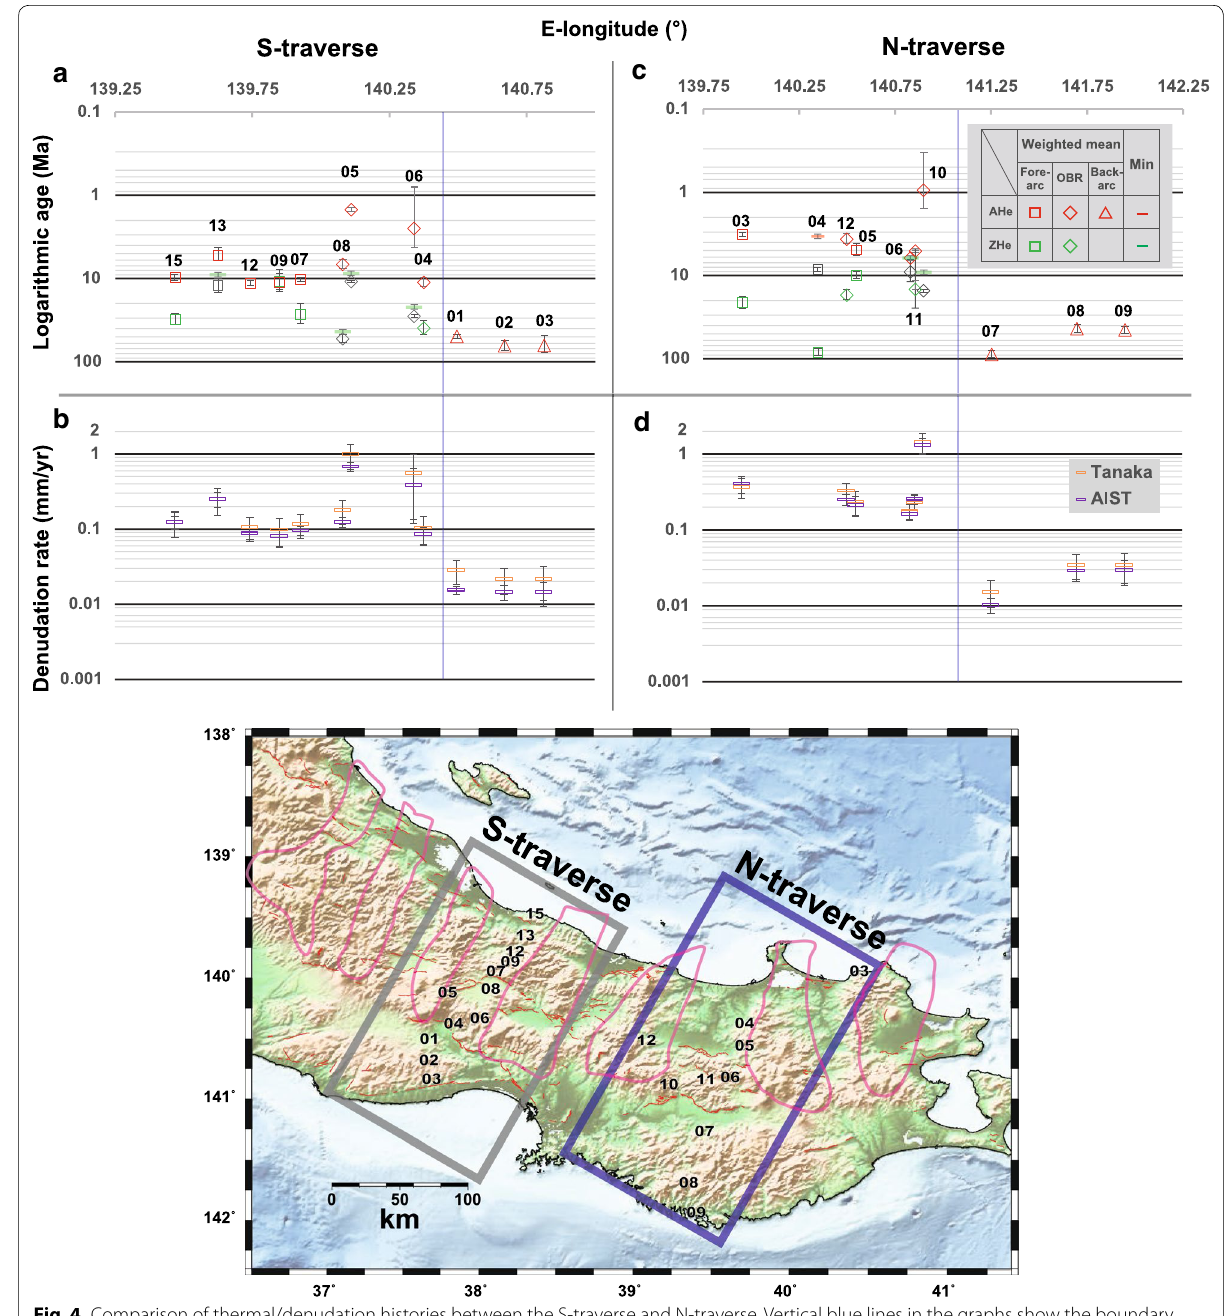
Fig. 4 Comparison of thermal/denudation histories between the S-traverse and N-traverse. Vertical blue lines in the graphs show the boundary between the fore-arc side and the OBR/back-arc side. Numbers on the map denote the sample localities in the N- and S-traverse corresponding to the sample codes in the graphs ( a , c ). Pink lines show hot fingers (Tamura et al. 2002). The map was drawn using GMT (Wessel and Smith 1991) and 30 arc-second grid of the General Bathymetric Chart of the Oceans (GEBCO). Active fault traces in red lines are cited from Nakata and Imaizumi (2002). a AHe/ZHe ages and denudation rates plot along the S-traverse. Weighted mean ages and minimum ages within 95% confidence intervals ± were plotted using data from Sueoka et al. (2017) after Fitzgerald et al. (2006). Gray data for ZHe show less reliable because their grain ages are over-dispersed. b Mean denudation rates and their uncertainties along the S-traverse. These rates were reported from Sueoka et al. (2017) using geothermal gradients of Tanaka et al. (2004). Data calculated using the database of GSJ (2009) were computed in this study. c AHe/ZHe ages and denudation rates plot along the N-traverse. Weighted mean ages and minimum ages within 95% confidence intervals were plotted after ± Fitzgerald et al. (2006). Gray data are less reliable because their grain ages are over-dispersed. d Mean denudation rates and their errors along the N-traverse. These rates were calculated using geothermal gradients from Tanaka et al. (2004) and GSJ (2009). FST04 was not calculated because its weighted mean age was not